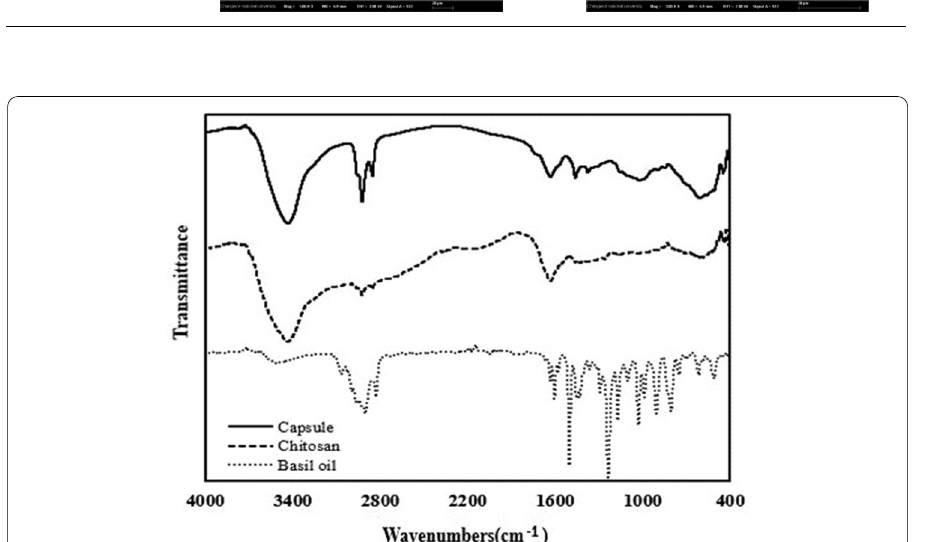
Fig. 3 FT‑IR spectra of microcapsuls, chitosan and basil